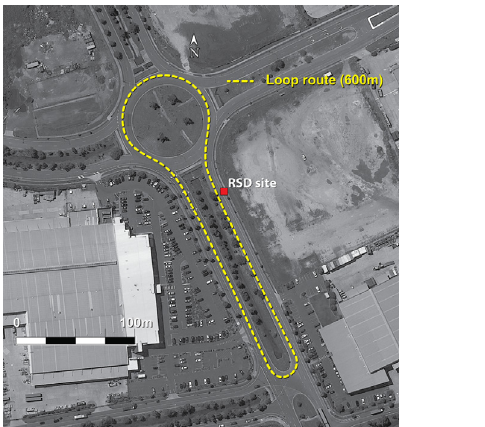
Figure 1. Remote sensing device (RSD) test route at the commercial RSD site.